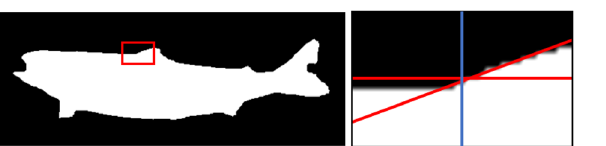
Figure 5. Localization of the upper fin beginning. Left—Segmented fish with selected region of upper fin beginning. Right—Magnification of selected region; blue line—horizontal center of the image, red lines—lines fitted to the left and right halves of the border pixels. Produced by Matlab